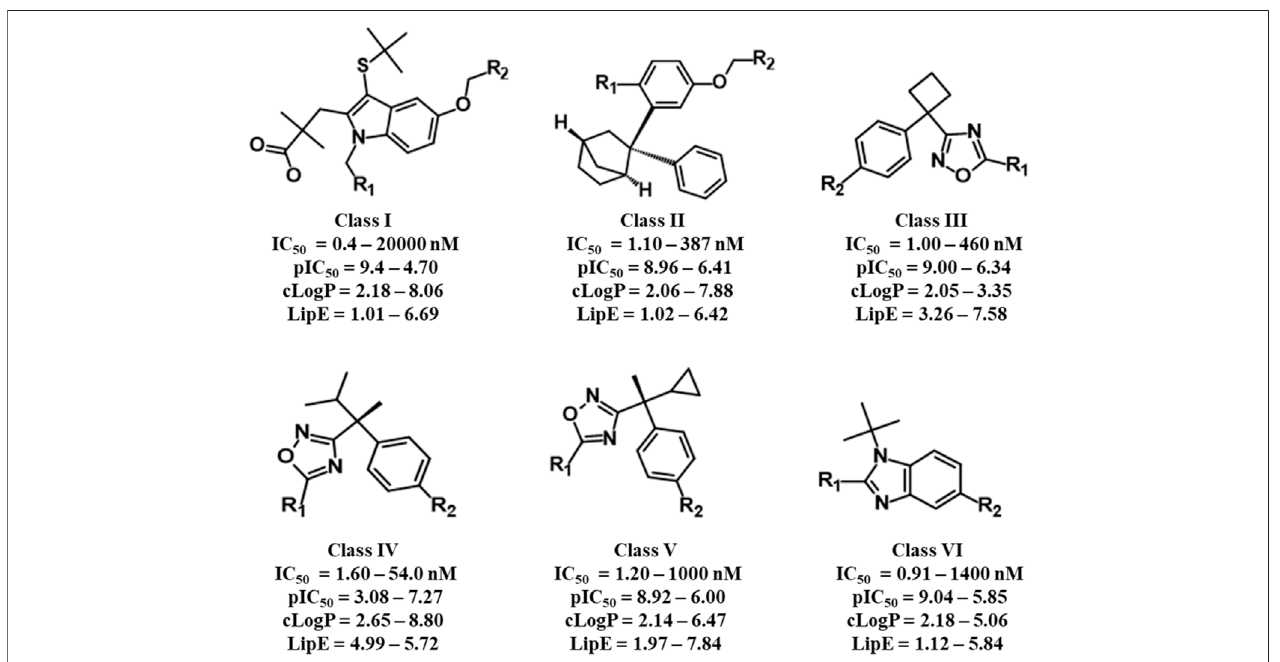
FIGURE1| CommonscaffoldsofsixclassesofFLAPinhibitorsusedforcommonscaffoldclusteringtoobtainthemostprobable3Dbindingposesforemployment in GRIND